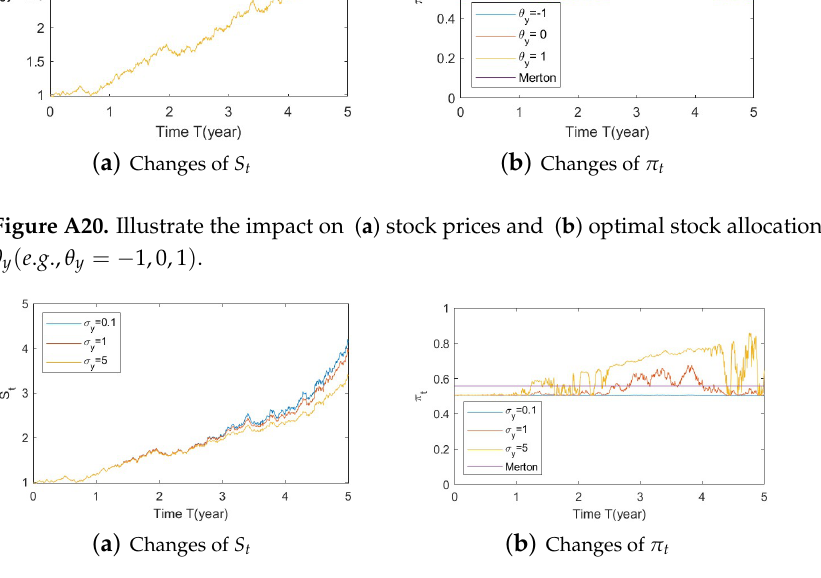
Figure A21. Illustrate the impact on ( a ) stock prices and ( b ) optimal stock allocations when varying σ y ( e . g ., σ y = 0.1,1,5 )